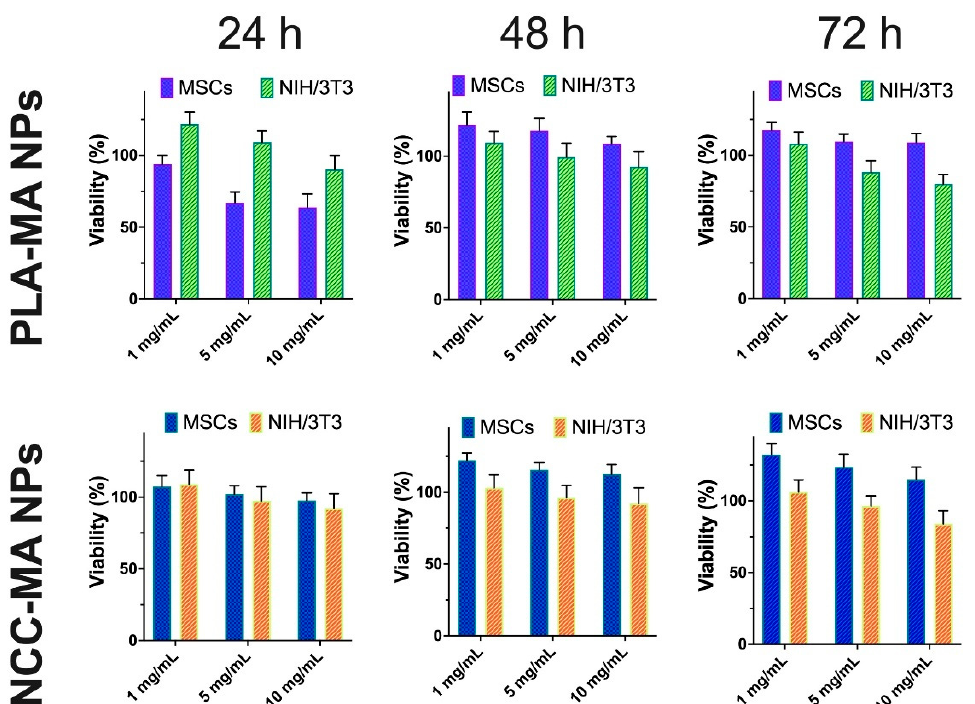
Figure 6. The effect of PLA-MA and NCC-MA particles on cell viability. MSCs and NIH/3T3 were exposed to the indicated concentrations of particles for 24, 48 and 72 h. Viability (%) is referred to the control, which was pure media without particles. Data are presented as mean ± SD (n = 5).